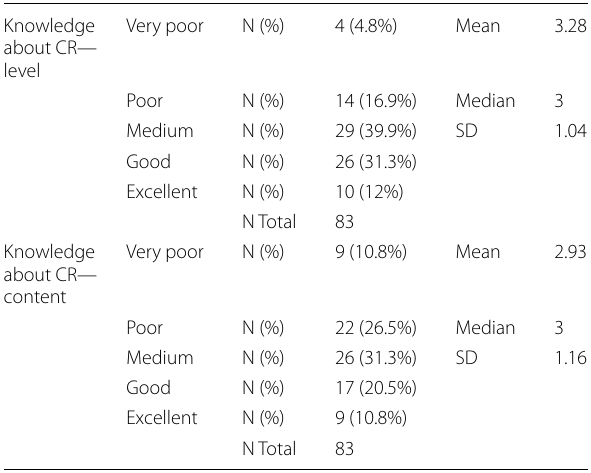
Table 2 Knowledge about cardiac rehabilitation (CR) among the